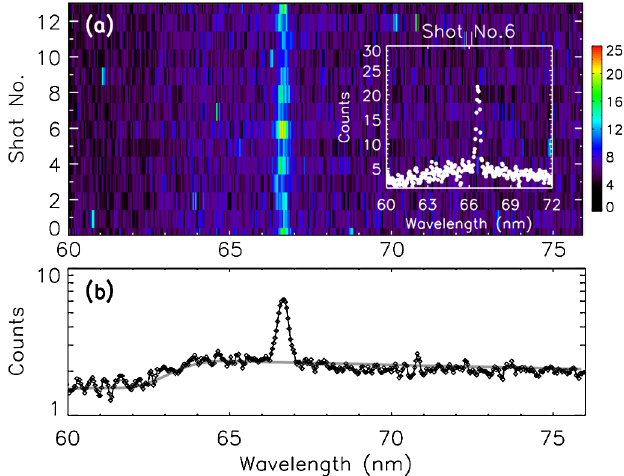
FIG. 6. Coherent fourth and sixth harmonic (66 and 44 nm) in linear polarization. Incoherent undulator harmonic background indicated separately. The radiator undulator is set to the second harmonic of the modulator undulator (131